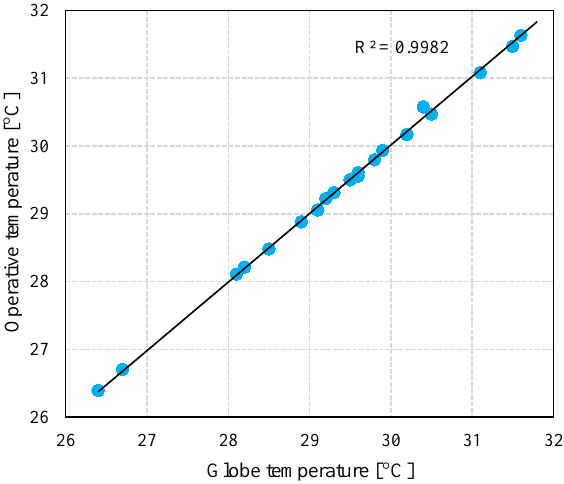
Figure 5. Relationship between calculated operative temperature and measured globe temperature.